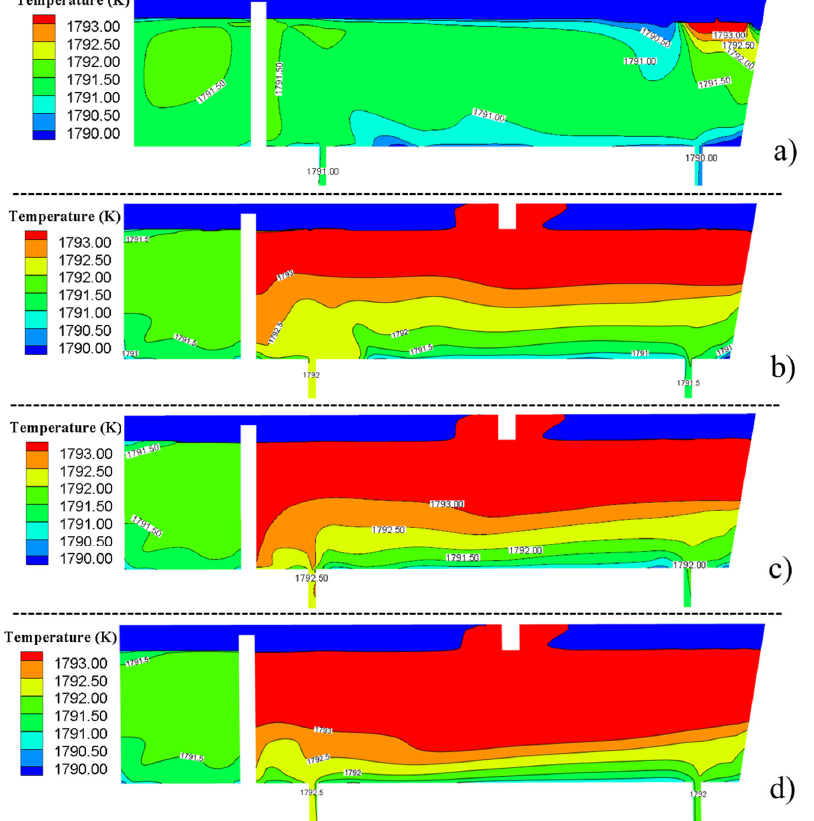
Figure 7. Temperature fields at plane 1 in tundish heated by plasma under different heating powers. ( a ) Without plasma heating, ( b ) 300 kW, ( c ) 500 kW and ( d ) 1000 kW.